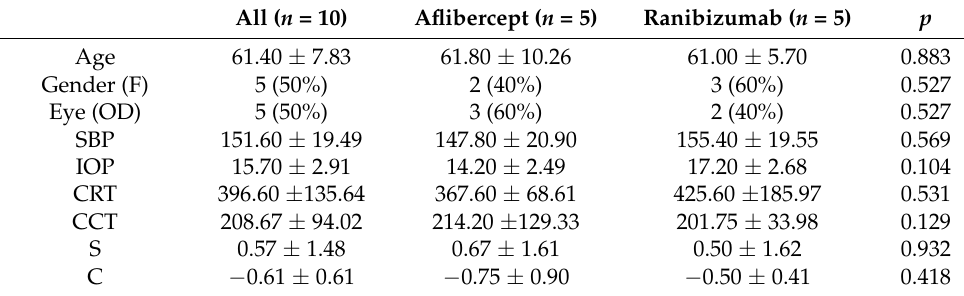
Table 1. The baseline